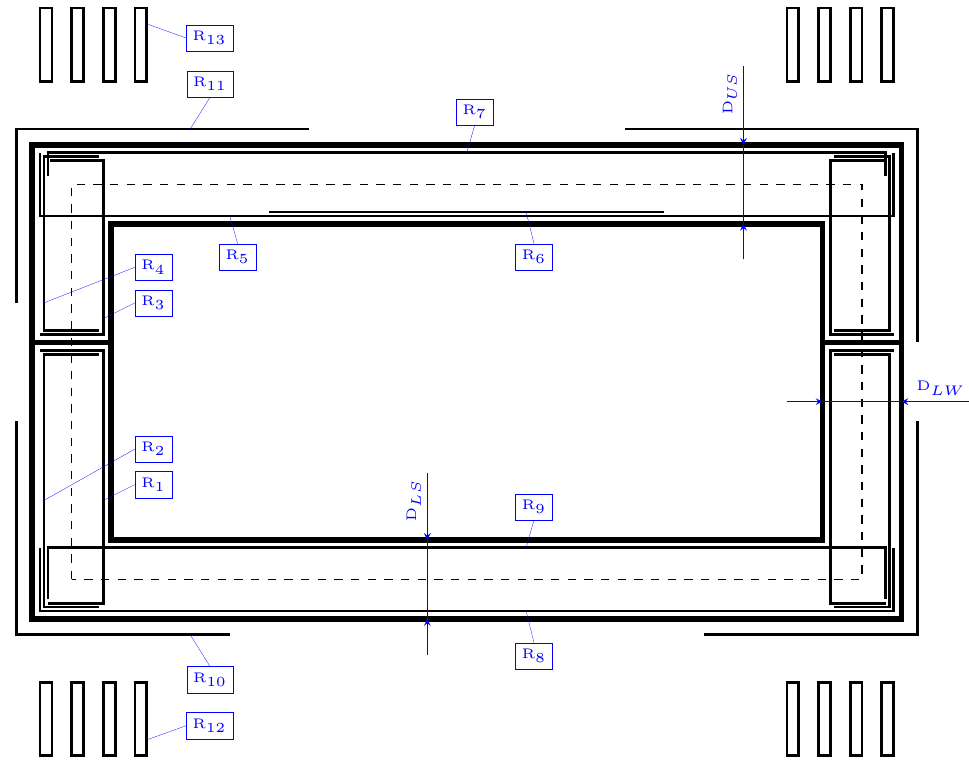
Figure 2. Set of variables considered in the RCPHF optimization problem. It is relevant to note that each of the optimization variables is discretized. The variables corresponding to the width of the slabs and lateral walls can adopt values every two centimetres within the stipulated range. In addition, the shear reinforcement branches can take spacing values every five centimetres within the limit values. The diameter of the passive reinforcement can vary along the standard’s values between 10 and 35 mm, and the number of bars can be any integer within the defined range. In this context, the set of variables considered, together with the number of values they can adopt during the optimization process of the frame and the limit values established, are listed in Table